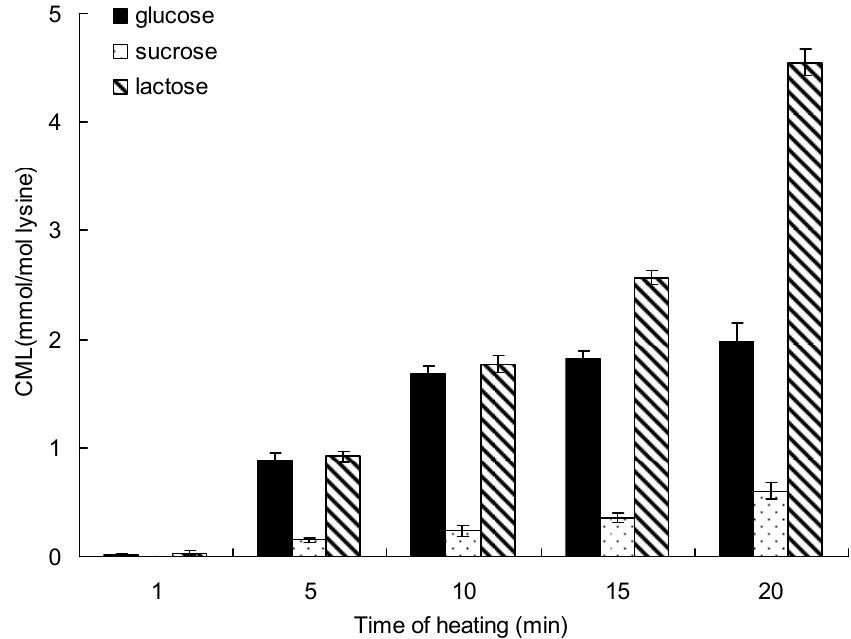
Figure 2. Formation of CML in saccharide-lysine over time. Data points are the mean of triplicate measurements ±